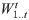
The delta density method conditions on real and simulated observations up to week u − 1 when building a probability distribution over the observation at week u.This figure demonstrates the process for drawing a single trajectory from the Markovian delta density estimate, ignoring the data revision process. The latest ILINet report, W1..tt, which incorporates observations through week 48, is shown in black. Kernel smoothing estimates for future values at times u from t + 1 to T are shown in blue, as are simulated observations drawn from these estimates. Past seasons’ trajectories are shown in red, with alpha values proportional to the weight they are assigned by the kernel Iu.